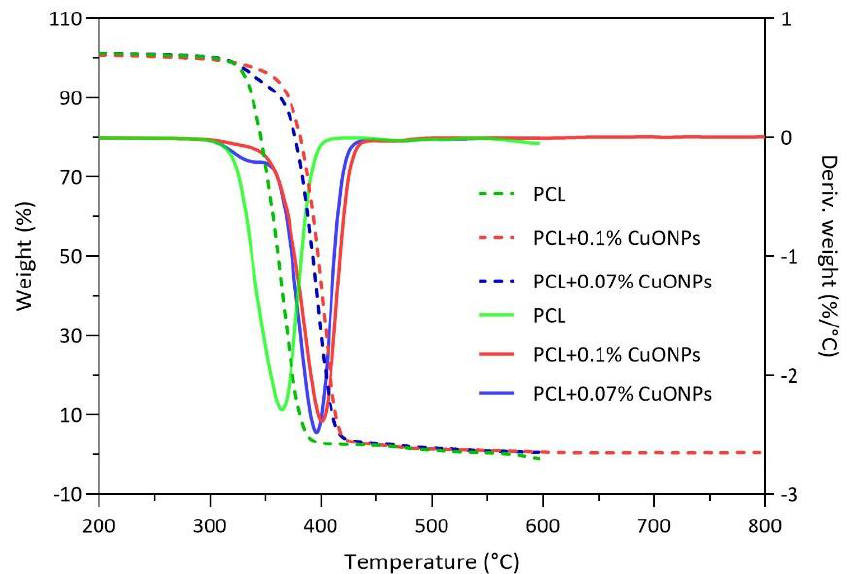
Figure 5. Thermal stability and degradation of active films with a heating rate of 10 °C min −1 for all the studied samples. The solid lines correspond to the weight (%), while the dashed lines correspond to the derivate of the weight (%/°C).